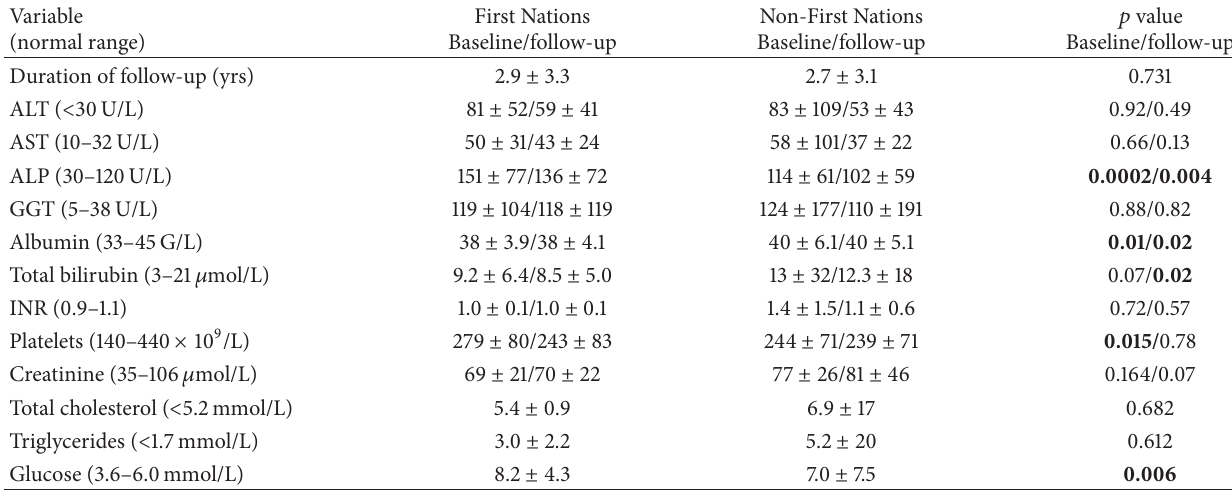
Table 2: Laboratory findings in First Nations and Non-First Nations patients with nonalcoholic fatty liver disease ∗ . Variable (normal range)